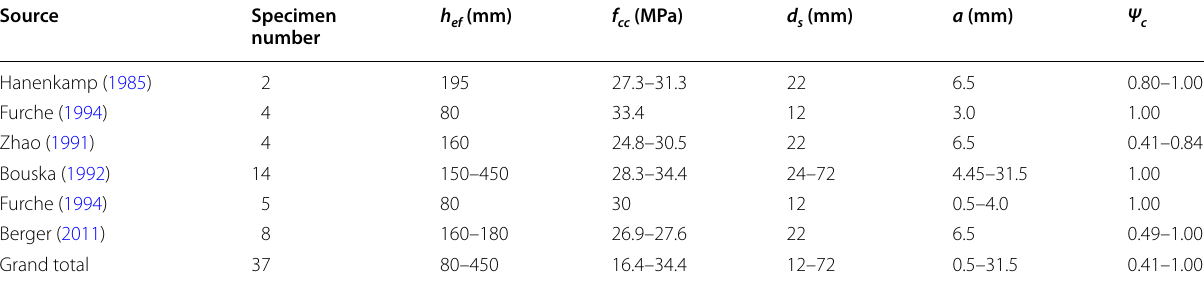
Table 3 Design parameters of the collected load–deformation